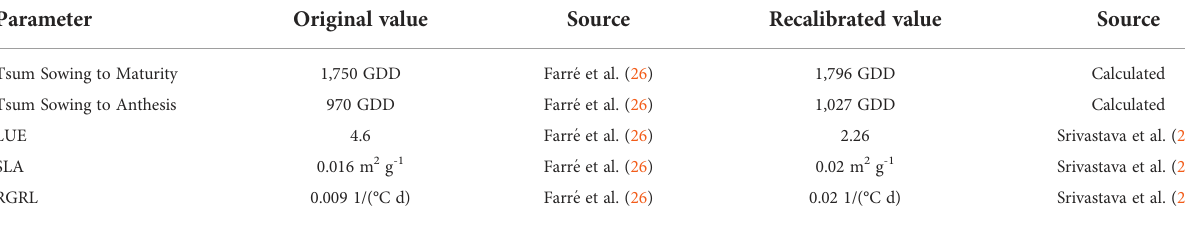
TABLE 5 Calibrated parameters to simulate the potential yield of maize in Ghana.